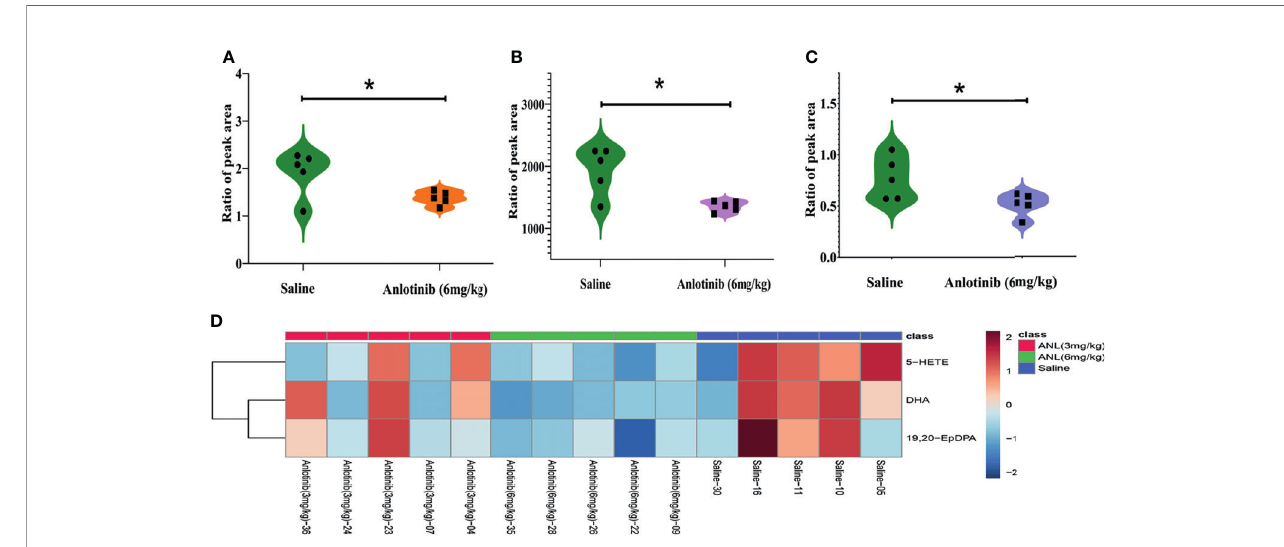
FIGURE 5 | The three signi fi cant changed metabolites in Renca cell syngeneic mice treated by anlotinib (6 mg/kg) when the cutoffs were set as VIP>1 and p<0.05. (A) 5-HE-TE. (B) DHA. (C) 19,20-EpDPA. (D) The heatmap of the above-mentioned metabolites. *p <